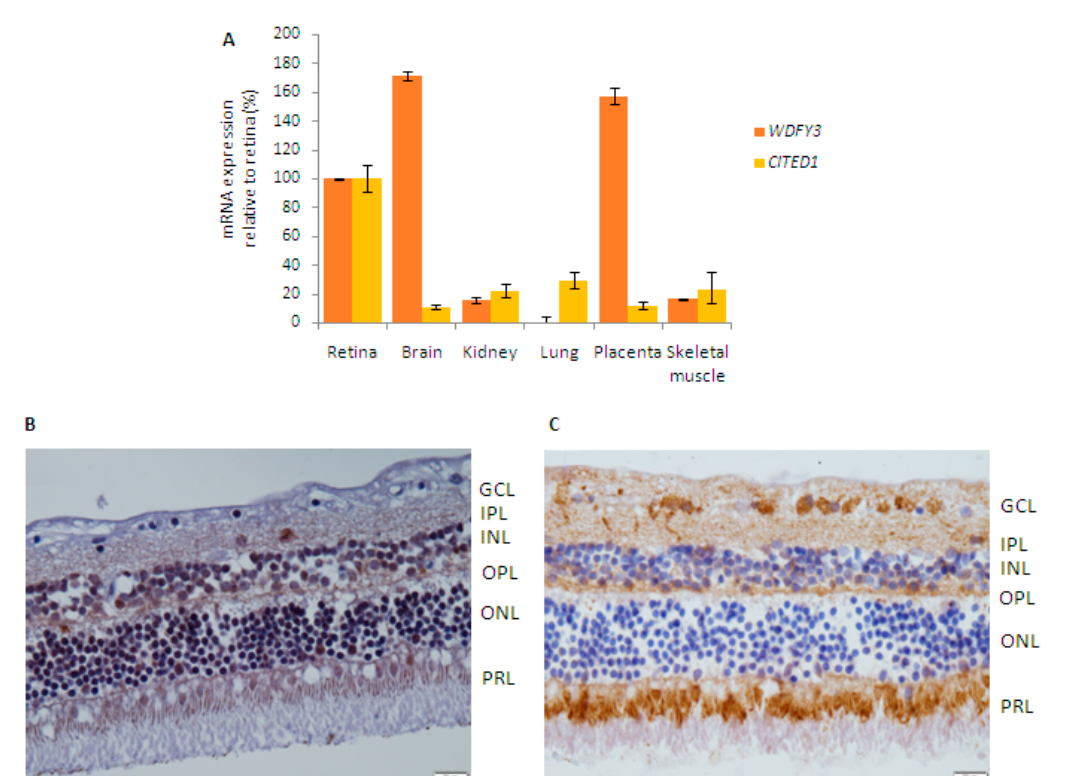
Figure 4. Expression analysis and localization of candidate genes. ( A ) Relative quantification of candidate genes WDFY3 (orange) and CITED1 (yellow) mRNA levels in different human tissues by real-time PCR. Data are represented as mean ± standard deviation. ( B ) Immunohistochemical staining of CITED1 in human retina sections (image captured at 60x magnification). Expression of CITED1 was observed in the photoreceptor layer (PRL), the outer nuclear layer (ONL) and the inner nuclear layer (INL). ( C ) Immunohistochemistry of WDFY3 in human retina sections, showing expression of WDFY3 in the PRL and ganglion cell layer (GCL). Results are shown at 60x magnification, with a 20 µm microscopic length as standard length. IPL, inner plexiform layer; OPL, outer plexiform layer. Both images present a different white balance, as micrographs were taken at different times.